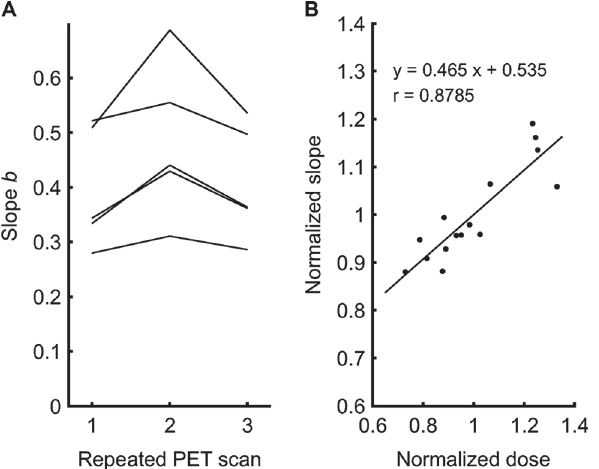
Fig 5. Effects on the noise characteristic of PET scans. A: Estimated slopes b of the linear regression between CV s2 and 1/n in five subjects submitted to multiple PET scans. The substantial inter-subject variability compared to the intra-subject variability was consistent with the expectation that differences in the amount of tissue surrounding the lungs cause differences in attenuation and, thus, in the actual number of detected decay events. B: Linear regression between the estimated slopes b normalized by each subject ’ s mean slope and the injected 13 NN doses normalized by each subject ’ s mean dose.